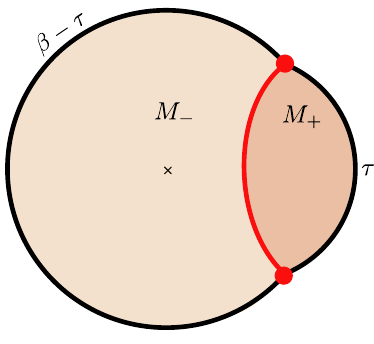
Figure 10 . Saddlepoint manifold X for τ < τ c